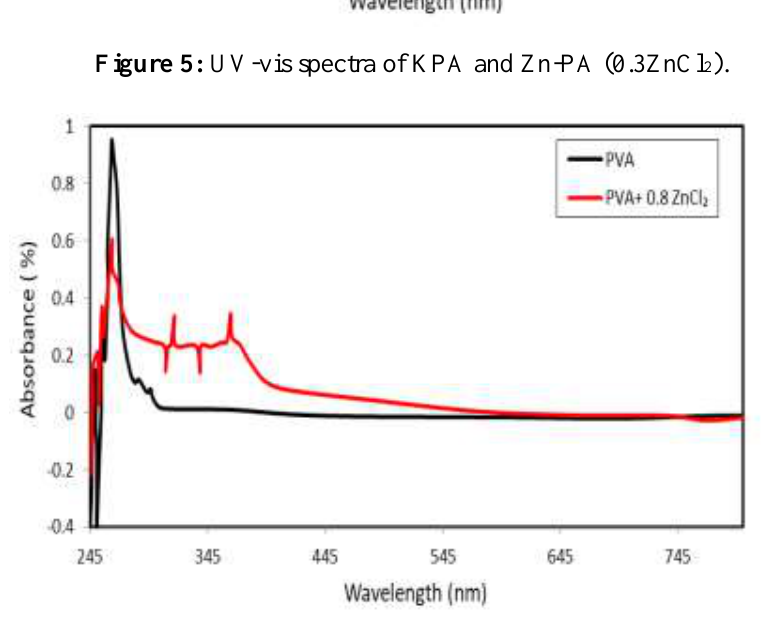
Figure 6: UV-vis spectra of PVA and Zn-PVA (0.8 g of ZnCl 2